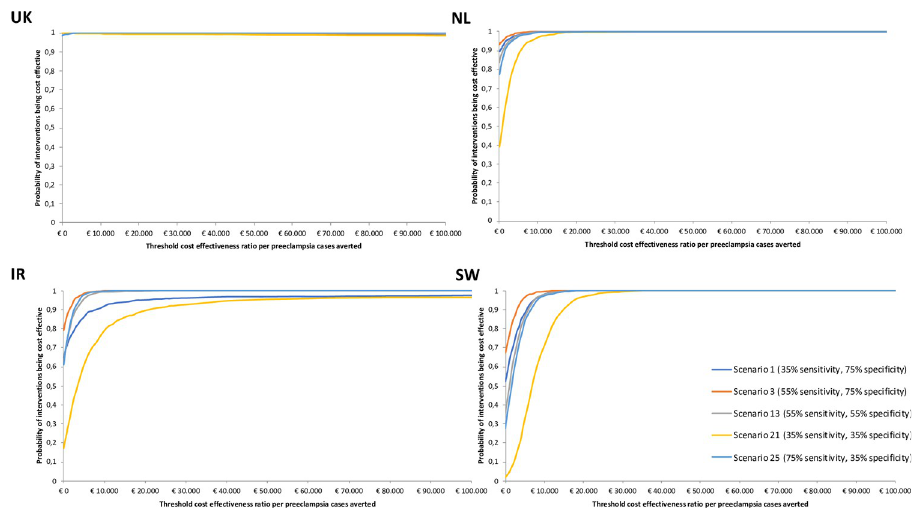
Fig 3. Cost-effectiveness acceptability curves for the new screening test in best-case scenario analyses in a different willingness to pay thresholds ranging from € 10,000 - € 100,000 per preeclampsia cases averted, in four participating countries. UK: United Kingdom, NL: The Netherlands, IR: Ireland, SW: Sweden.